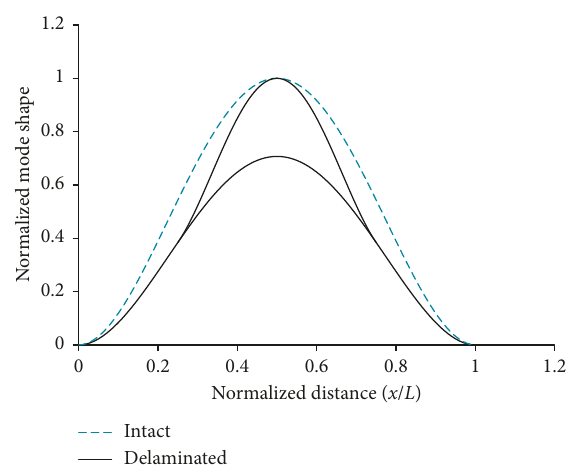
Figure 8: The first opening mode shape for a delaminated beam with a central delamination on the midplane using “free mode” 0.5, M zz / M b 0.4, and dif- (cid:31) (cid:31)